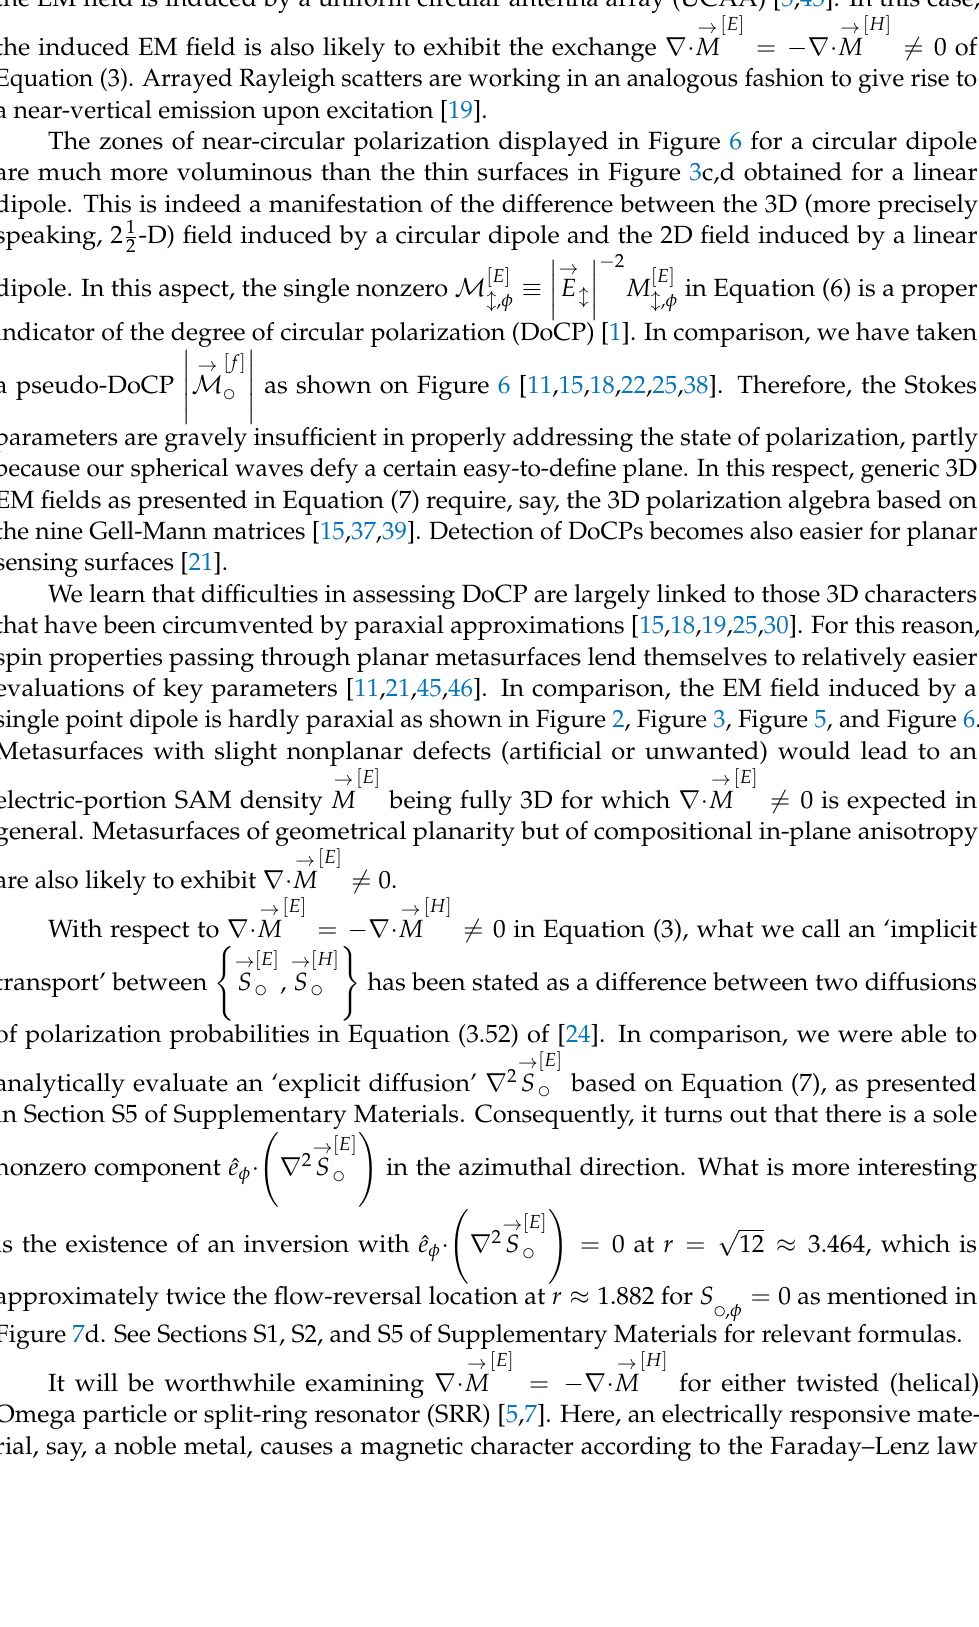
    Figure 1. ( a ) Decomposition of a Poynting vector P into an orbital energy flux O and a spin Figure 1. ( a ) Decomposition of a Poynting vector P into an orbital energy flux O and a spin     energy flux S energy flux S . Besides, M is a spin angular momentum (SAM) density. ( b ) The coordinate . Besides, M is a spin angular momentum (SAM) density. ( b ) The coordinate systems. On the origin lies a primary electric point dipole represented by its unit vector ˆ p . ( c ) A systems. On the origin lies a primary electric point dipole represented by its unit vector ˆ p . ( c ) A   Figure 1. ( a ) Decomposition of a Poynting vector P into an orbital energy flux O and a spin linear dipole ˆ p with its dipole axis lying parallel to the vertical axis leads to a pencil-hull-like linear dipole ˆ p with its dipole axis lying parallel to the vertical axis leads to a pencil-hull-like     energy flux S . Besides, M is a spin angular momentum (SAM) density. ( b ) The coordinate tapered cylindrical surface designating higher values for the degree of circular polarization (DoCP). tapered cylindrical surface designating higher values for the degree of circular polarization (DoCP).   systems. On the origin lies a primary electric point dipole represented by its unit vector ˆ p . ( c ) A with its dipole axis lying on the horizontal plane leads to a filled solid with its dipole axis lying on the horizontal plane leads to a filled solid ( d ) A circular dipole ˆ p ( d ) A circular dipole ˆ p   Figure 1. ( a ) Decomposition of a Poynting vector P into an orbital energy flux O and a spin   linear dipole ˆ p with its dipole axis lying parallel to the vertical axis leads to a pencil-hull-like ○ ○ cone of higher values of DoCP. cone of higher values of DoCP.  energy flux S . Besides, M is a spin angular momentum (SAM) density. ( b ) The coordinate    tapered cylindrical surface designating higher values for the degree of circular polarization (DoCP).  systems. On the origin lies a primary electric point dipole represented by its unit vector ˆ p . ( c ) A Figure 1. ( a ) Decomposition of a Poynting vector P into an orbital energy flux O and a spin with its dipole axis lying on the horizontal plane leads to a filled solid ( d ) A circular dipole ˆ p    linear dipole ˆ p with its dipole axis lying parallel to the vertical axis leads to a pencil-hull-like energy flux S . Besides, M is a spin angular momentum (SAM) density. ( b ) The coordinate    ○ cone of higher values of DoCP. Figure 1. ( a ) Decomposition of a Poynting vector P into an orbital energy flux O and a spin  tapered cylindrical surface designating higher values for the degree of circular polarization (DoCP). systems. On the origin lies a primary electric point dipole represented by its unit vector ˆ p . ( c ) A   energy flux S . Besides, M is a spin angular momentum (SAM) density. ( b ) The coordinate with its dipole axis lying on the horizontal plane leads to a filled solid ( d ) A circular dipole ˆ p linear dipole ˆ p with its dipole axis lying parallel to the vertical axis leads to a pencil-hull-like   systems. On the origin lies a primary electric point dipole represented by its unit vector ˆ p . ( c ) A ○ cone of higher values of DoCP. tapered cylindrical surface designating higher values for the degree of circular polarization (DoCP).  linear dipole ˆ p with its dipole axis lying parallel to the vertical axis leads to a pencil-hull-like with its dipole axis lying on the horizontal plane leads to a filled solid ( d ) A circular dipole ˆ p   tapered cylindrical surface designating higher values for the degree of circular polarization (DoCP). ○ cone of higher values of DoCP.  with its dipole axis lying on the horizontal plane leads to a filled solid ( d ) A circular dipole ˆ p  ○ Figure 7d. See Sections S1, S2, and S5 of Supplementary Materials for relevant cone of higher values of DoCP. 